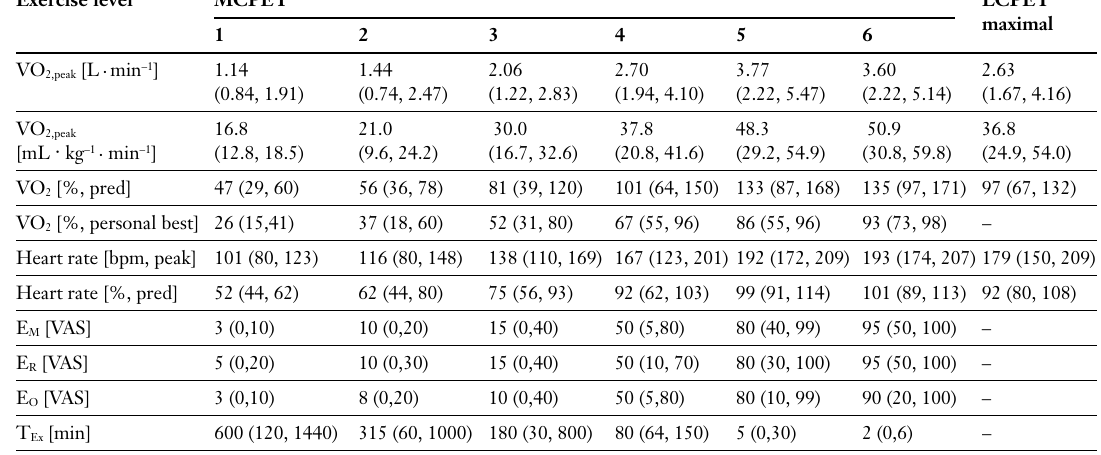
Figure 3 Correlation of peak oxygen uptake during LCPET and MCPET. The compari- son of VO 2 [peak] measured during LCPET in the labora- tory and outside on a running track (MCPET) showed a significant linear correlation (r 2 = 0.9). However, VO 2 [peak] was on average 21% (SD 9%) higher with MCPET compared to LCPET. As the com- parative measure- ments using a meta- bolic calibrator all were within 3%, this difference is unlikely to be the conse- quence of a technical